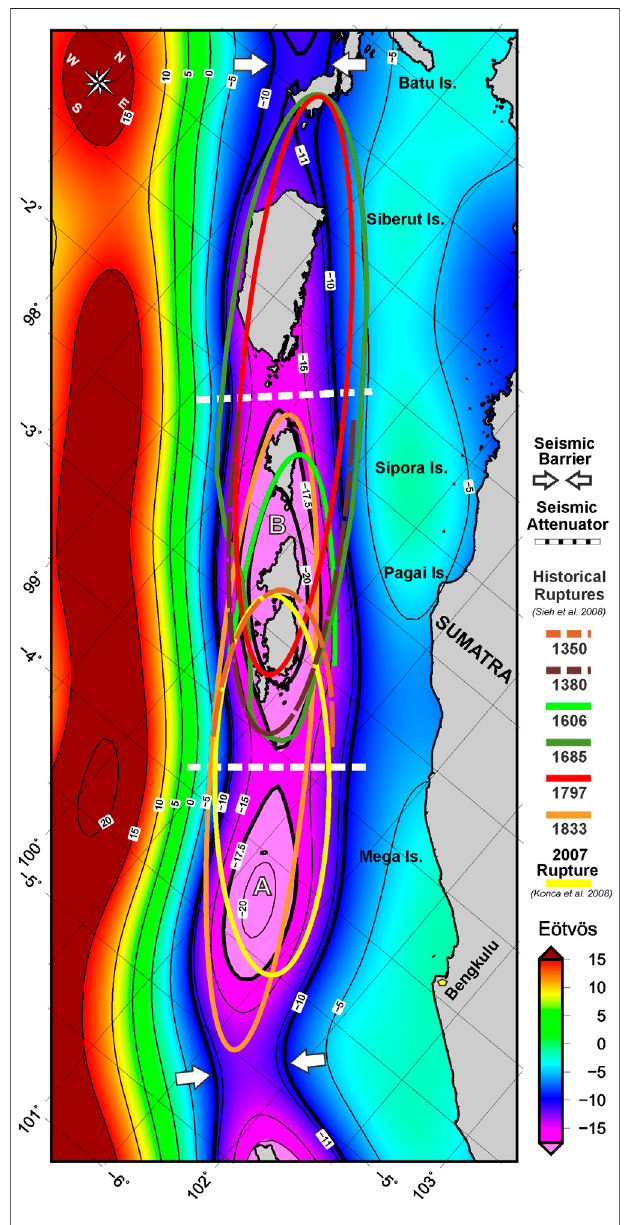
FIGURE 9 | Approximate rupture areas for recent (Konca et al., 2008) andhistoricalearthquakes(Siehetal.,2008)superimposedtothetopography corrected vertical gravity gradient (Tzz) obtained from GOCE model GO_CONS_GCF_2_DIR_R6 up to N (cid:1) 200 (Bruinsma et al., 2014). Dashed white line indicates the location of regions that behaved as seismic energy attenuators; white arrows indicate the existence of a seismic barrier that arrested rupture